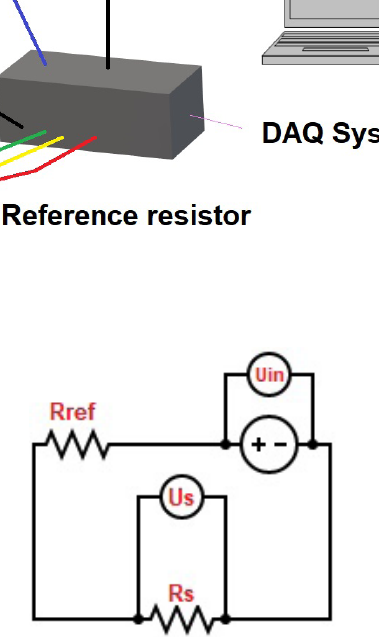
Figure 7. Electrical circuit for measuring electrical resistance (adapted from 53